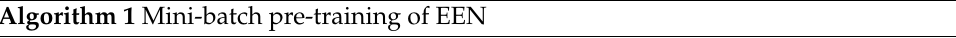
Algorithm 1 Mini-batch pre-training of EEN tion